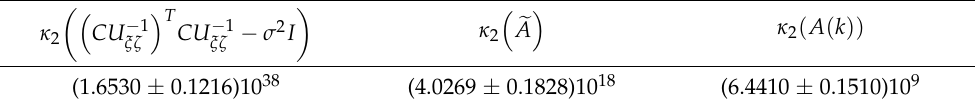
Table 4. The mean values of the condition numbers of the matrices and their standard deviations.